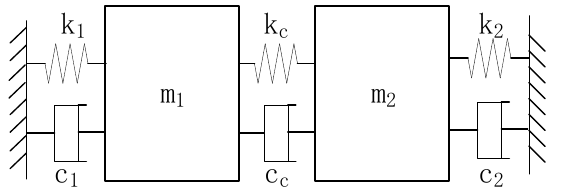
Figure 1. The mechanical model of a 2-DOF vibration